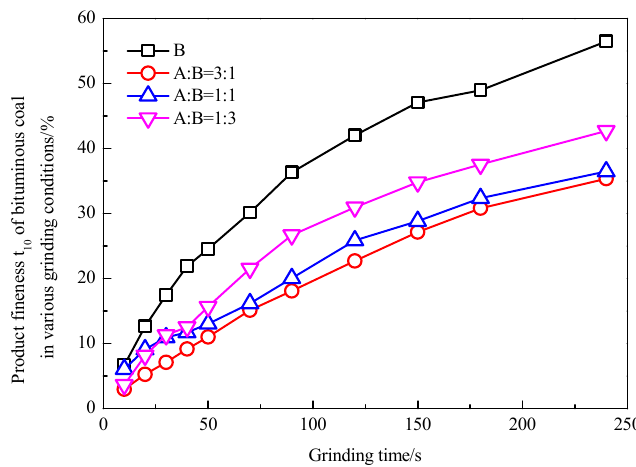
Figure 6. Product fineness t 10 of bituminous coal for various grinding conditions and times.